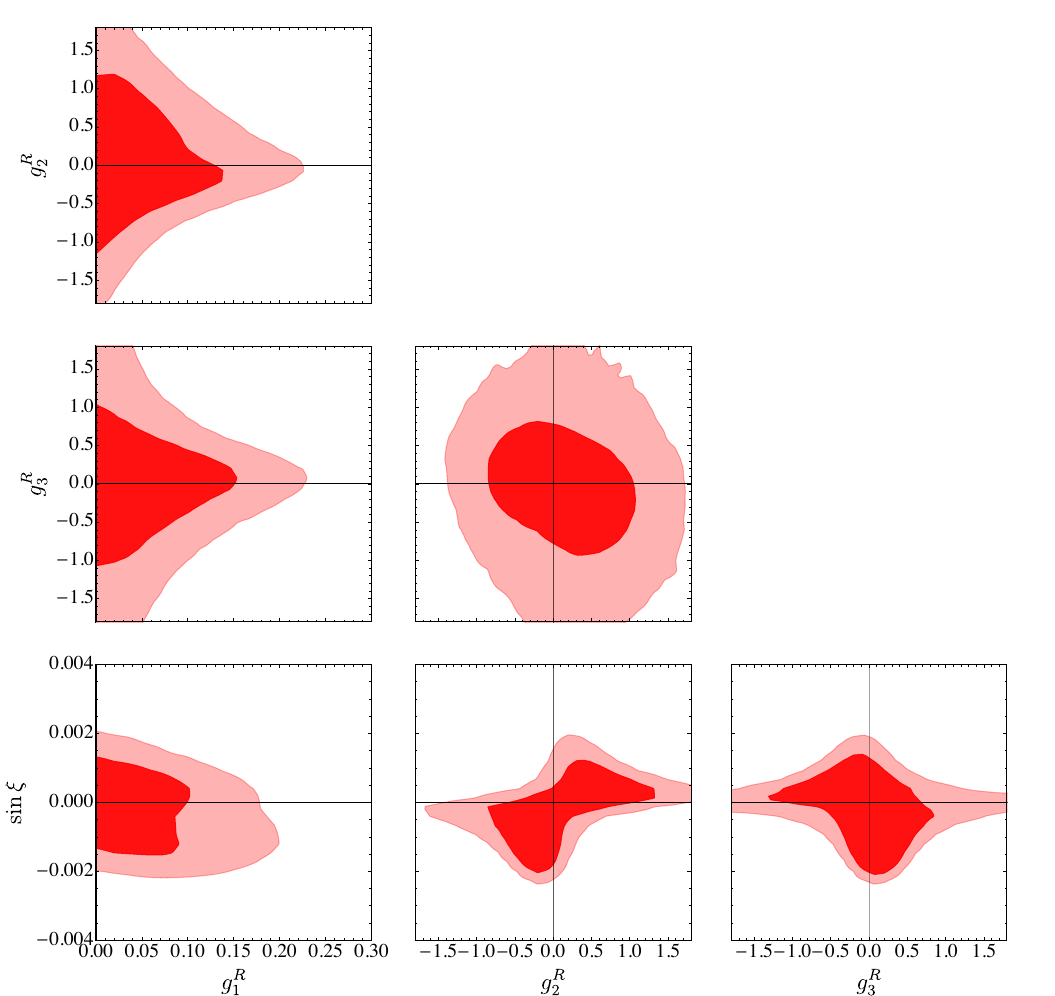
Figure 7. 68% and 95% CL regions for the LFUV case with right-handed couplings g R